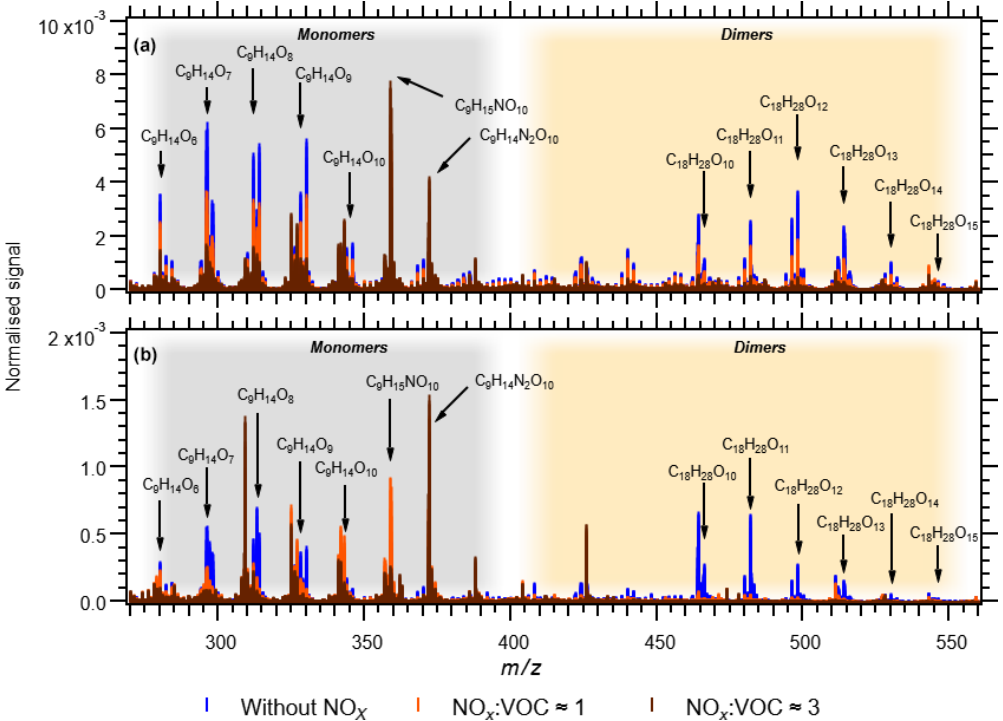
Figure 4. Comparison of mass spectra of HOM and nitrates. Panel (a) shows experiments 4 (blue), NOx1 (orange) and NOx3 H (brown). Panel (b) shows experiments 2 (blue), NOx3 L (orange) and NOx9 (brown).